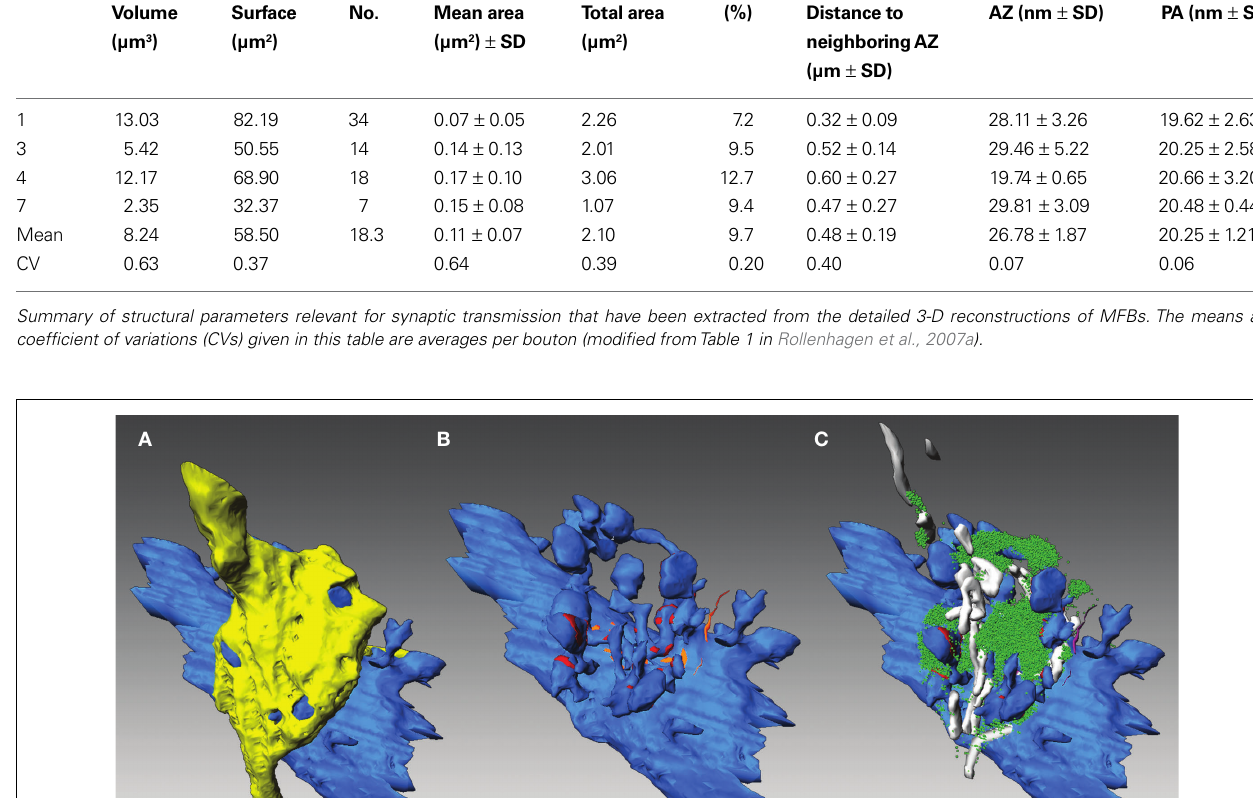
were mainly located on the spiny excrescences, whereas PAs were exclusively found at the dendritic shaft. (C) Organization of the pool of synaptic vesicles (green dots) at an individual MFB. Here, the pool was distributed throughout the entire nerve terminal. Mitochondria (in white) formed either cluster-like arrangements or bands associated with the pool of synaptic vesicles (green dots).